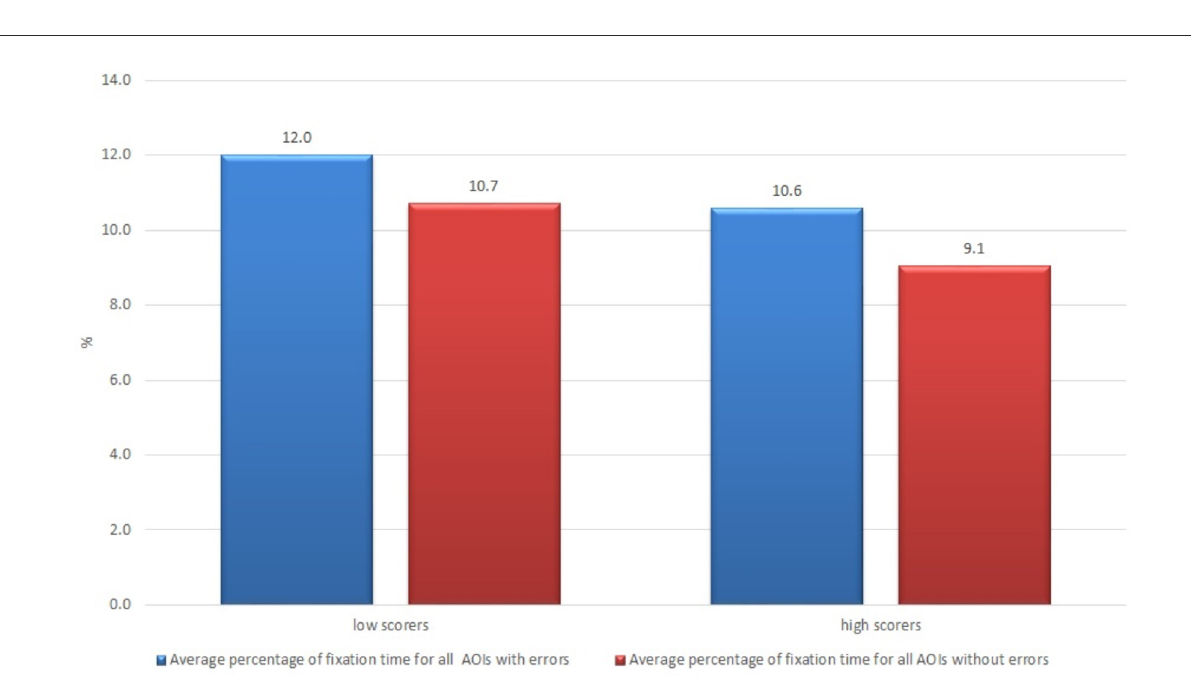
professional users of machine translation, i.e., translators